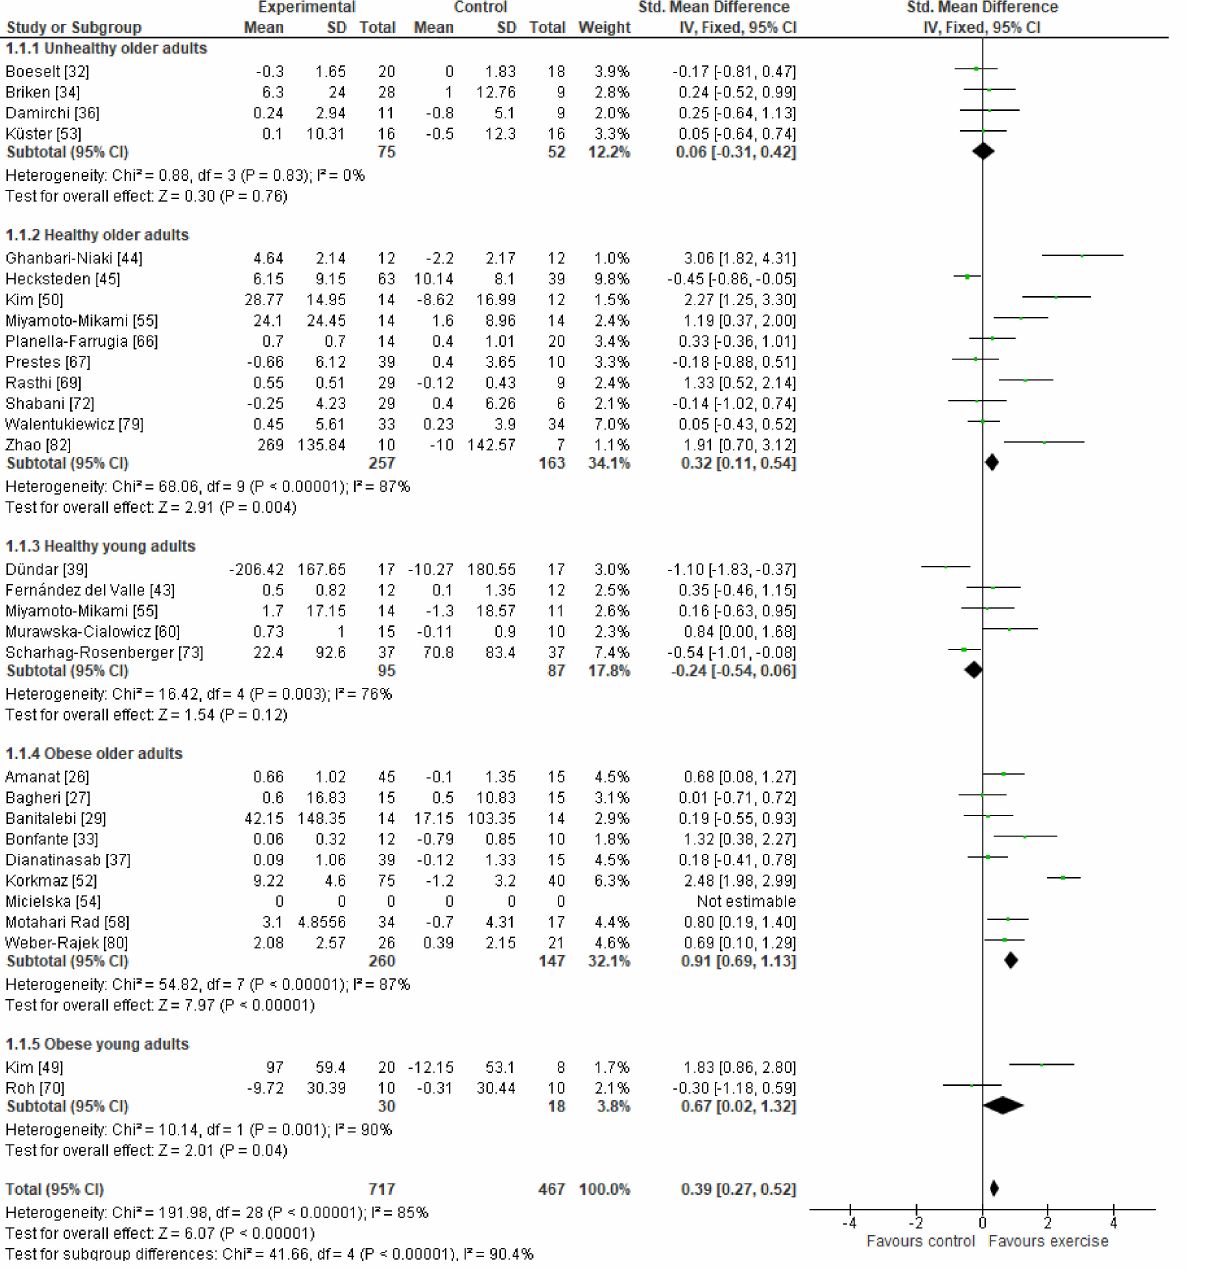
Figure 4. The forest plots of effect sizes for all the